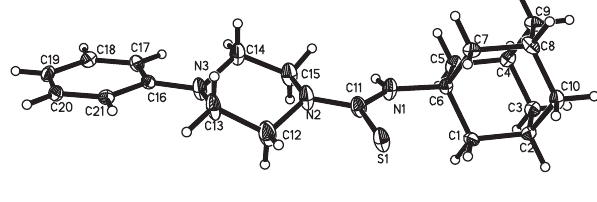
Table 1: Data collection and handling.